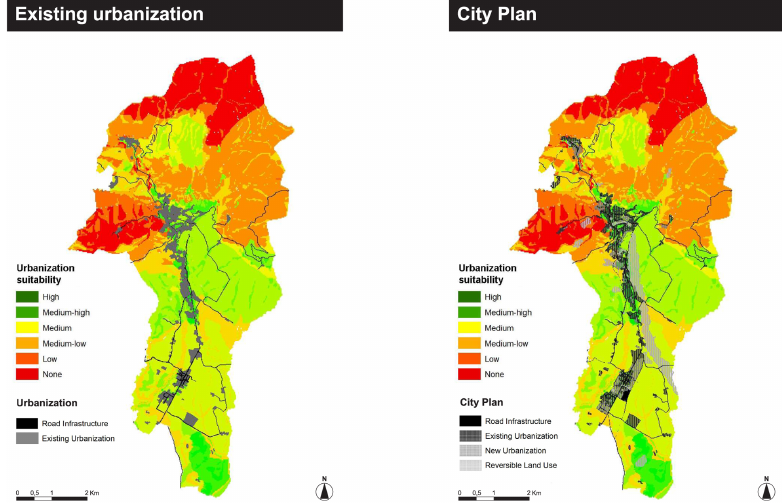
Fig. 7. Land consumption before and after the City